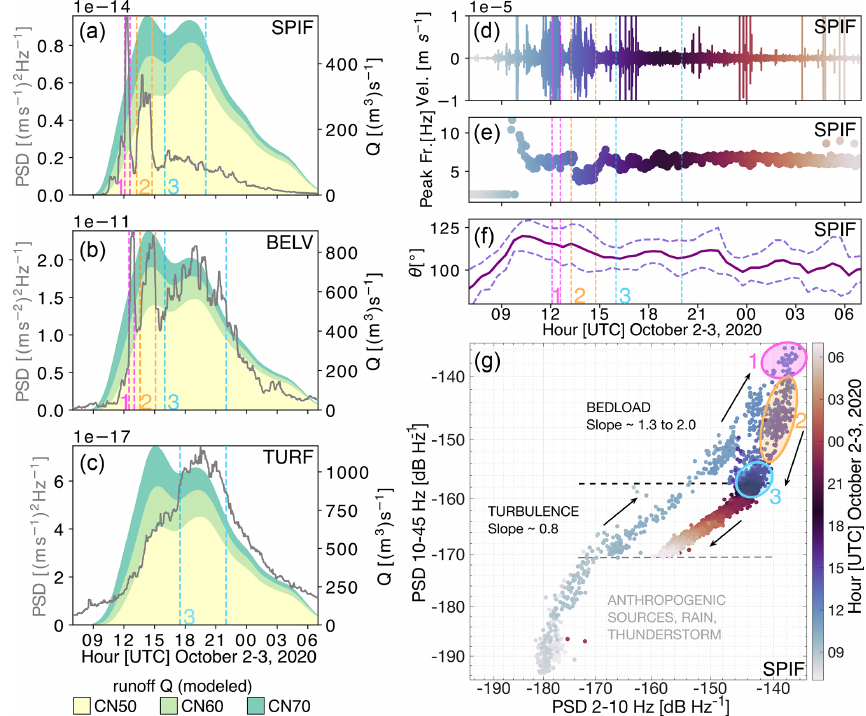
Figure 2. Analysis of continuous seismic signals recorded during Storm Alex. Seismic power (PSD) averaged between 1 and 20Hz and recorded at stations (a) SPIF, (b) BELV, and (c) TURF. The results of the runoff simulation are marked in yellow (CN60), light green (CN70), and green (CN80), where CN denotes three different basin saturation scenarios: CN70 (moderate saturation), CN60, and CN50 (rather dry conditions). Seismic power is smoothed with a moving time window of 30min, and the runoff is calculated with a 5min time step. (d) Vertical ground velocity recorded at the SPIF station filtered in 1–50Hz. (e) Peak frequency calculated for each 200s segment. Peak frequency and the corresponding time segment are marked in the same color. (f) Back azimuth (smoothed over three consecutive 30min time windows) calculated at the SPIF station averaged over 3–8Hz and its standard deviations (dashed lines). (g) Seismic power in the 2–10Hz frequency band versus seismic power in 10–45Hz at the SPIF station. All results are shown from 07:00UTC on 2 October to 07:00UTC